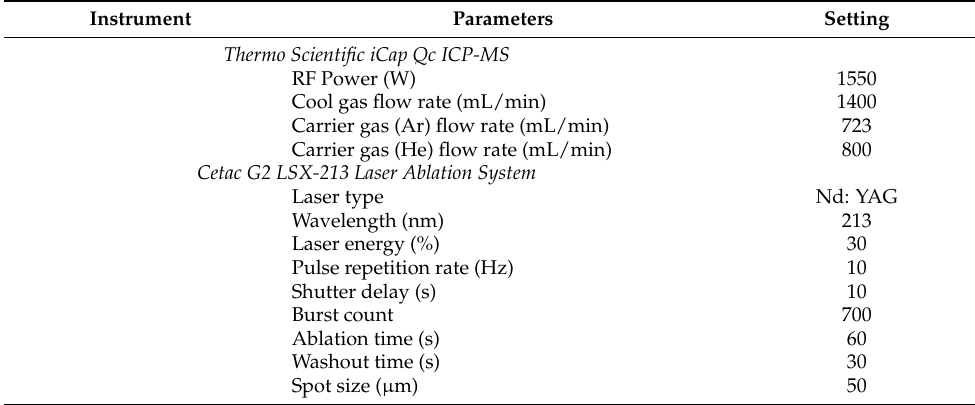
Table A5. Fort Payne Millbig Bottom, Bruton Gap Kb-X, Tidwell Hollow